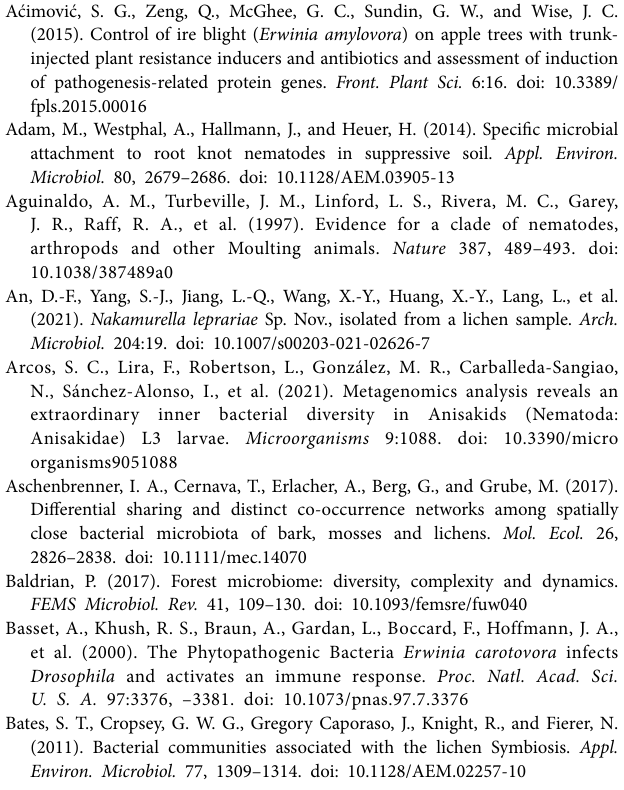
Supplementary Table S4 | Relative abundance of all analyzed OTUs in each sample. Supplementary Table S5 | Relative abundance of each OTU by level of Contrast 1 (Location).